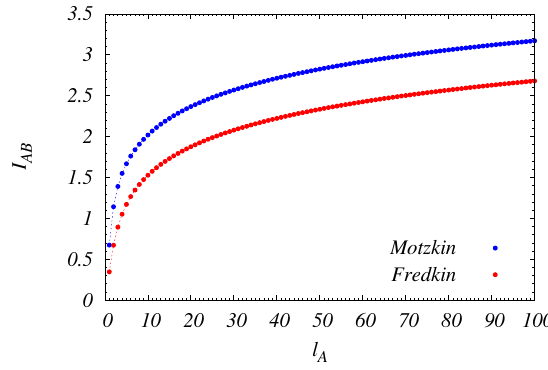
Figure 13: Mutual information between two regions of spins deep inside the bulk of a colorless Fredkin (red bottom line) and Motzkin (blue top line) chain as a function